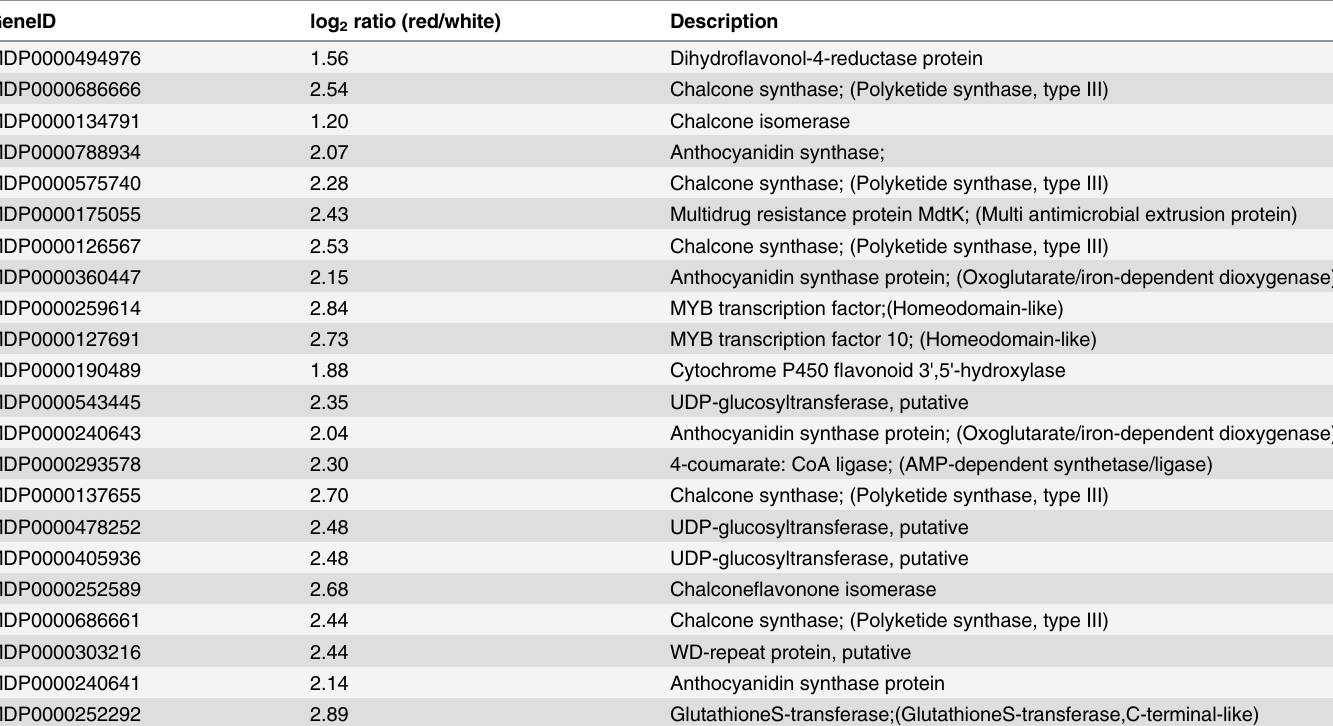
Table 2. Up-regulated genes involved in flavonoid biosynthetic processes in red-fleshed apples. GeneID log 2 ratio (red/white)